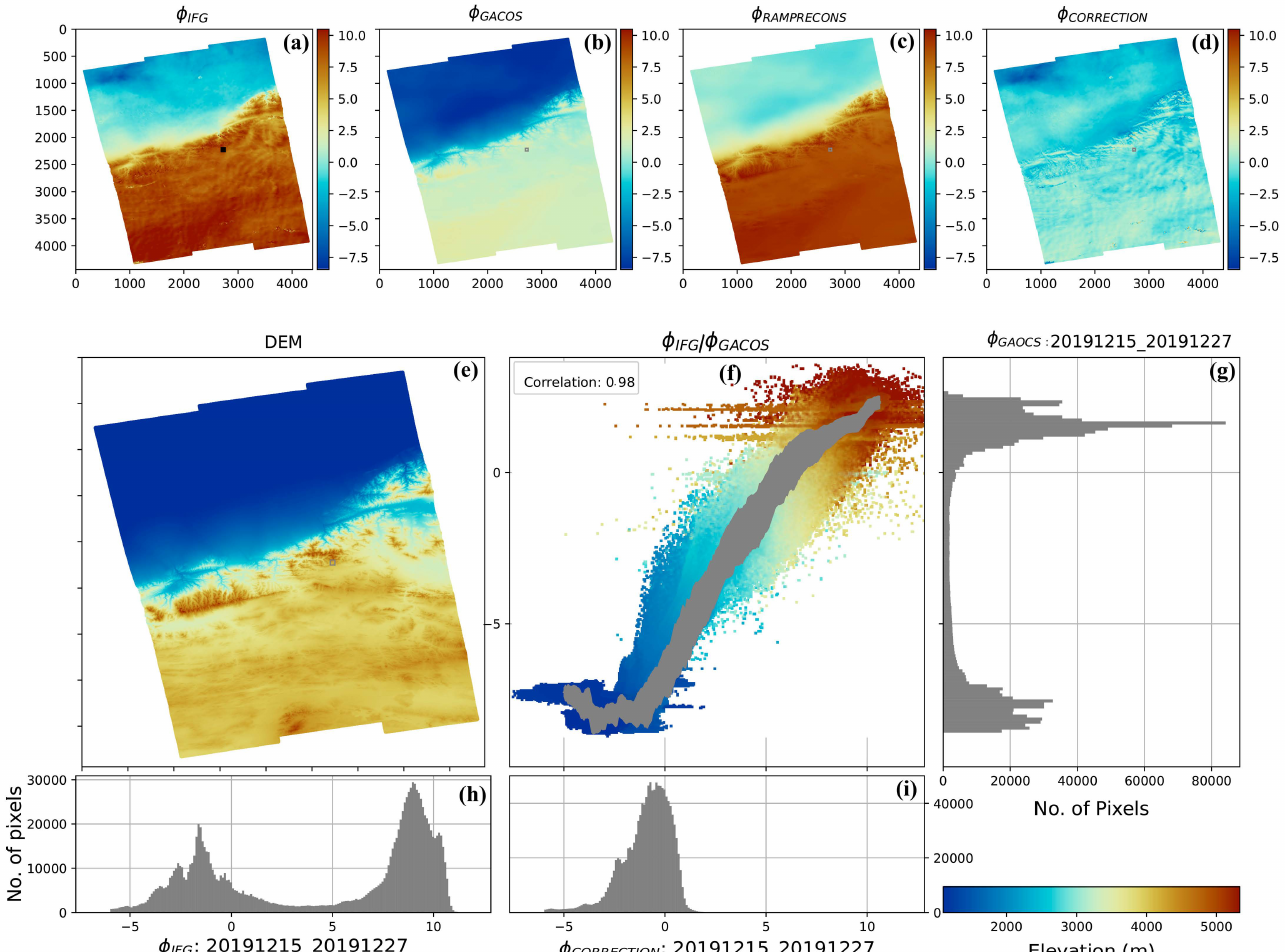
Figure 2. Example of an empirical correction of the stratified delays after the GACOS correction. ( a ) Interferogram for date pair 15–27 November 2019 (format: YYYYMMDD). ( b ) Modeled tropo- spheric delays using GACOS product. ( c ) Reconstruction of the stratified delays considering an empirical displacement-elevation relationship. ( d ) Corrected interferogram. ( e ) Digital Elevation Model from AW3D30. ( f ) Phase/GACOS correlation. ( g ) Histogram for reconstructed GACOS. ( h ) Histogram for original interferogram. ( i ) Histogram for corrected